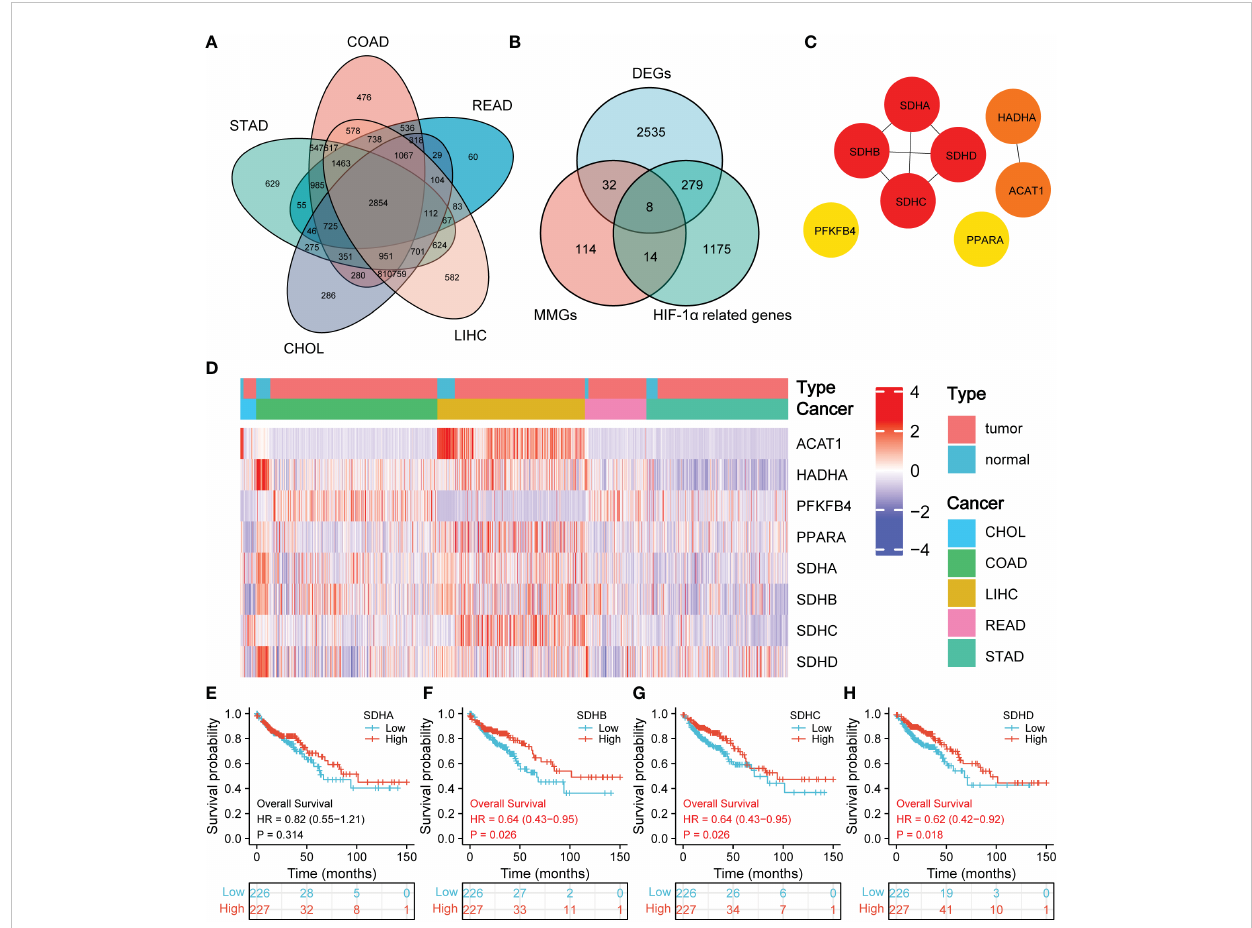
FIGURE 2 Prognostic signi fi cance of SDHs. (A) Venn diagram of DEGs in CHOL, COAD, LIHC, READ, and STAD. (B) Venn diagram of DEGs, MMGs, and HIF-1 a - related genes. (C) The network for 8 DEGs intersected. (D) Heatmap of SDHA, SDHB, SDHC, and SDHD between 41 normal tissues and 453 COAD patients. (E-H) Kaplan-Meier overall survival of SDHA, SDHB, SDHC, and SDHD in